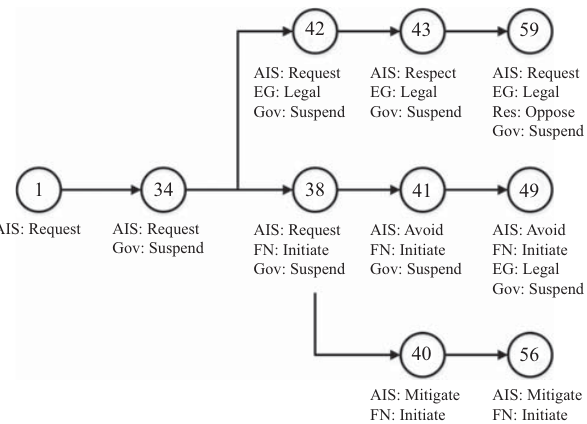
Figure 4. Potential evolution